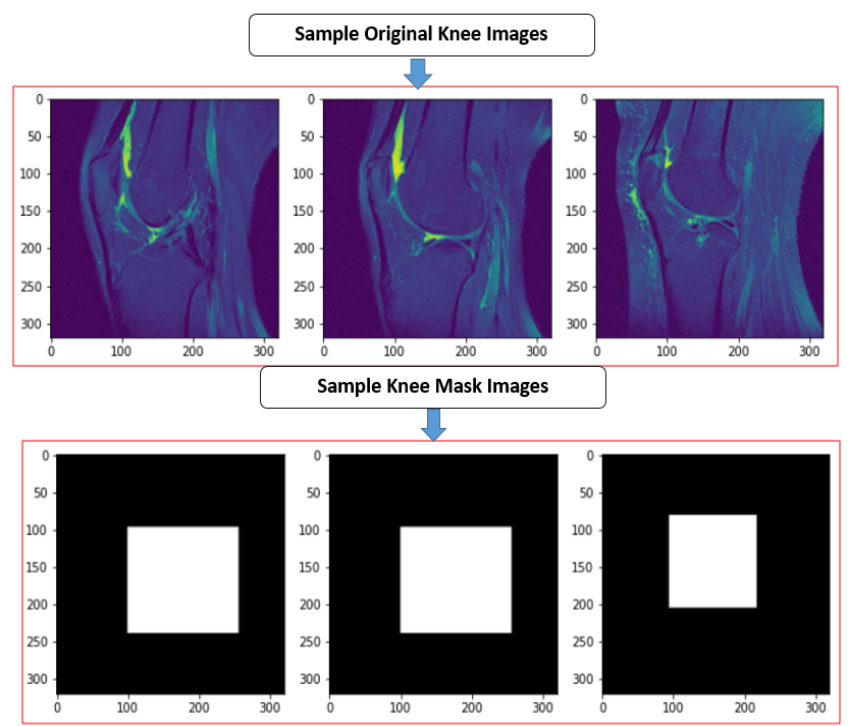
Figure 4. The sample true JPEG images and their knee mask images.